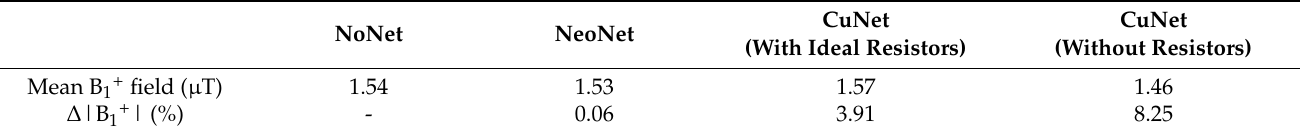
Figure 6. MRI data with EEG electrodes vs. NoNet vs. NeoNet. ( a – c ) Comparison of the T1 and ( d , e ) T2 sequences of adult volunteers. Images ( a , d ) taken with EEG electrodes show the presence of a B 1 artifact (blue arrow), whereas no artifacts were visible with both NoNet ( b , e ) and NeoNet ( c , f ). Table 3. B 1 transmit field uniformity from Sim4Life Numerical Simulations on MARTIN [19].